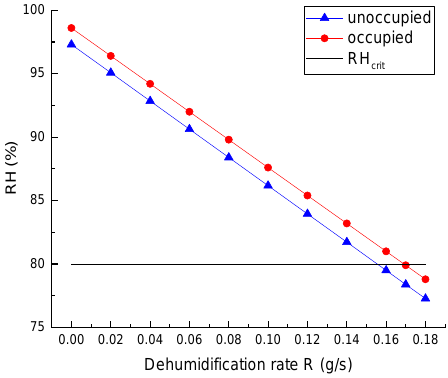
Figure 10. The highest indoor air RH under different dehumidification rates.